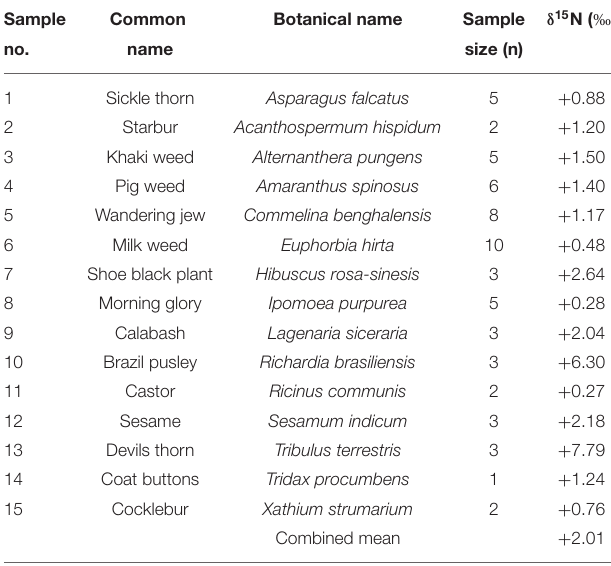
TABLE 1 | Source and B-values of grain legumes used for estimating %Ndfa. TABLE 2 | Shoot δ 15 N ( ‰ ) values of reference plants used for estimating %Ndfa in legumes.